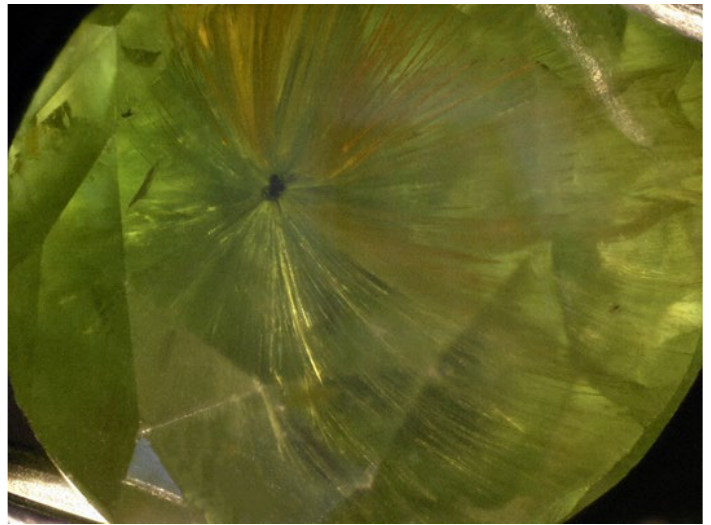
Figure 2. “Horsetail” inclusions in the demantoid from the Bobrovka river placer (Elizavetinskiy village, the Central Urals); image width 4 mm. Photo by E.S. Karaseva.